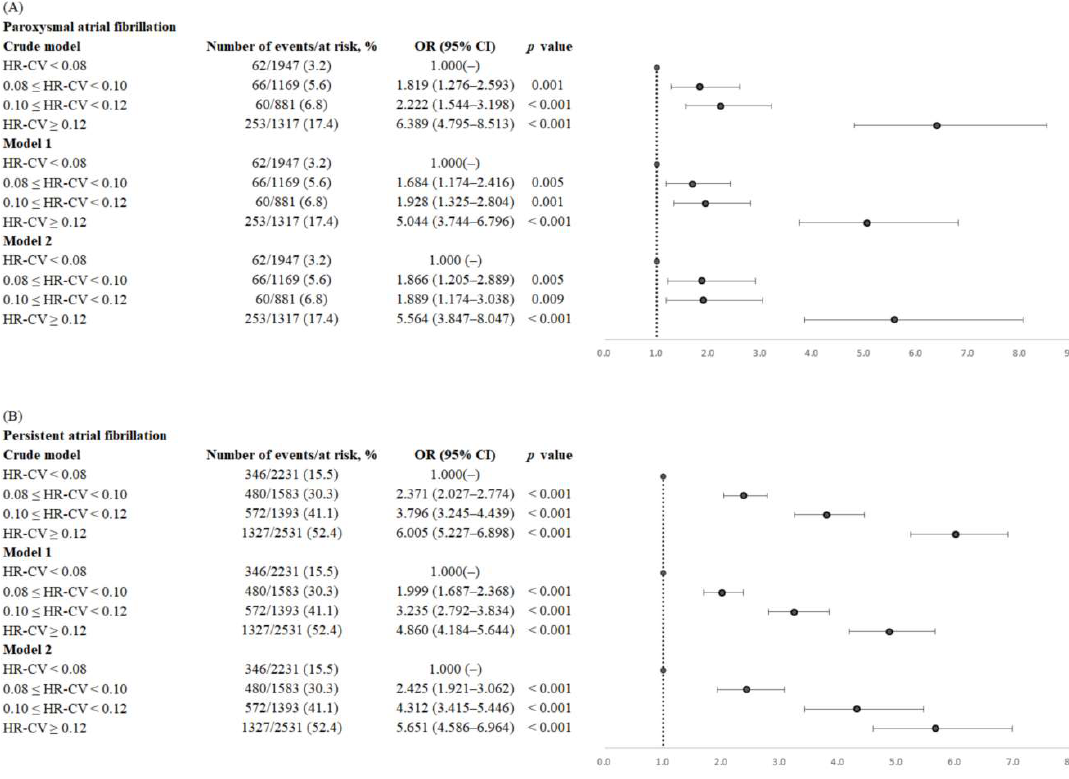
Figure 2. Forest plots of crude and adjusted ORs (95% CIs) of ( A ) paroxysmal atrial fibrillation and ( B ) persistent atrial fibrillation by HR-CV increments. The analyses were adjusted for age, sex, and eNIHSS score in model 1, as well as for all confounders considered in the fully adjusted model (model 2), namely age, sex, eNIHSS score, history of hypertension, diabetes mellitus, dyslipidemia, coronary artery disease, congestive heart failure, a history of cancer, smoking status, body mass index, total cholesterol, triglycerides, creatinine, alanine aminotransferase, mean heart rate, mean systolic blood pressure, and mean diastolic blood pressure. Abbreviations: OR, odds ratio; CI, confidence interval; HR-CV, coefficient of variation in HR; eNIHSS, estimated National Institutes of Health Scale.